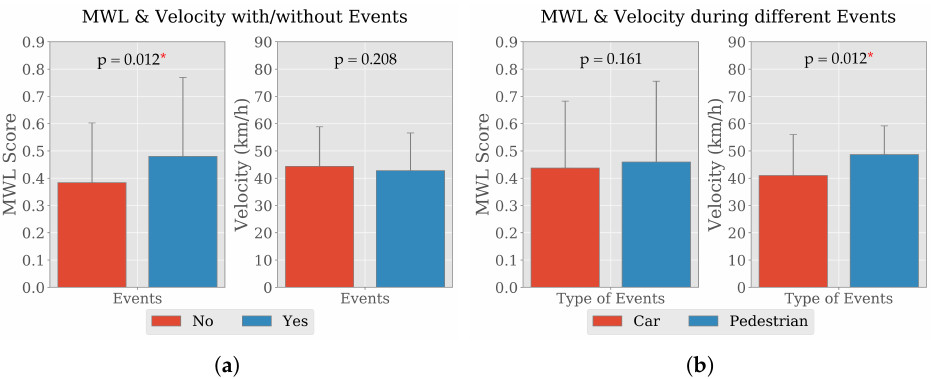
Figure 3. Average MWL score and velocity with standard deviation calculated from the data of nine participating drivers with respect to events. Sub-figure ( a ) illustrates the variation of MWL score and velocity with/without the presence of events and Sub-figure ( b ) illustrates the the effect of car and pedestrian on MWL score and velocity. The p -values obtained from the two-sided Wilcoxon signed-rank tests are presented and significant values at 5% confidence interval are marked with asterisks